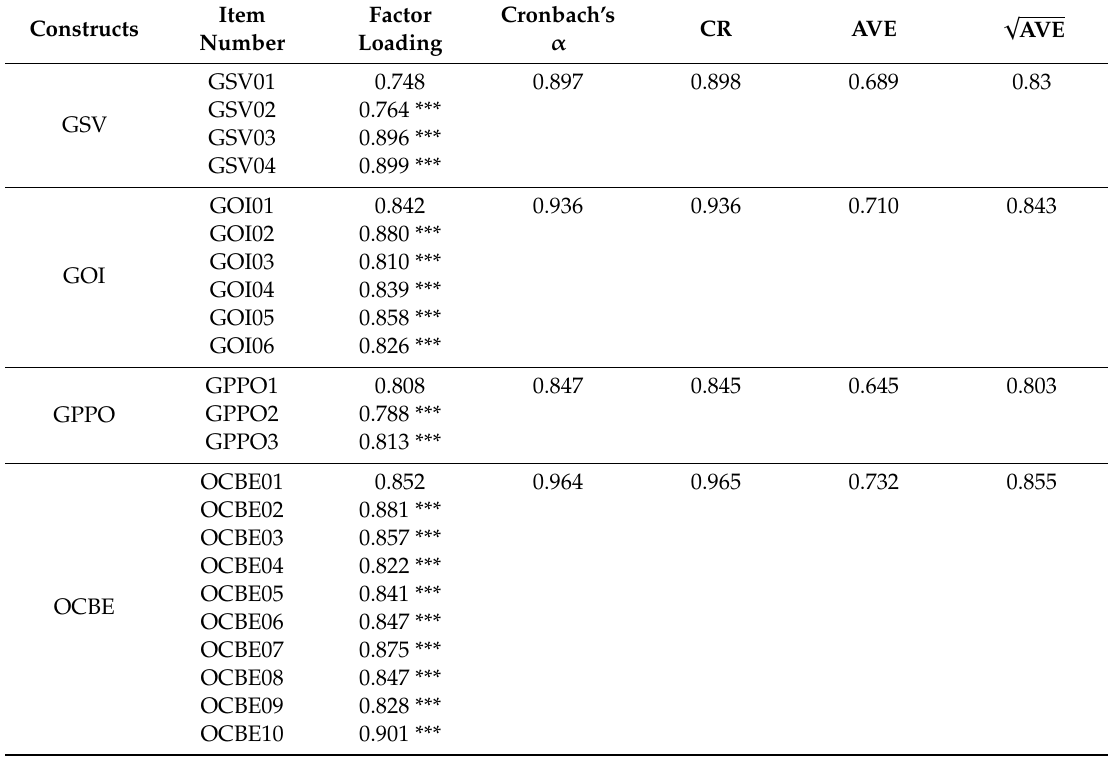
Table 4. Item loadings ( λ ) and Cronbach α coe ffi cients and AVEs of the